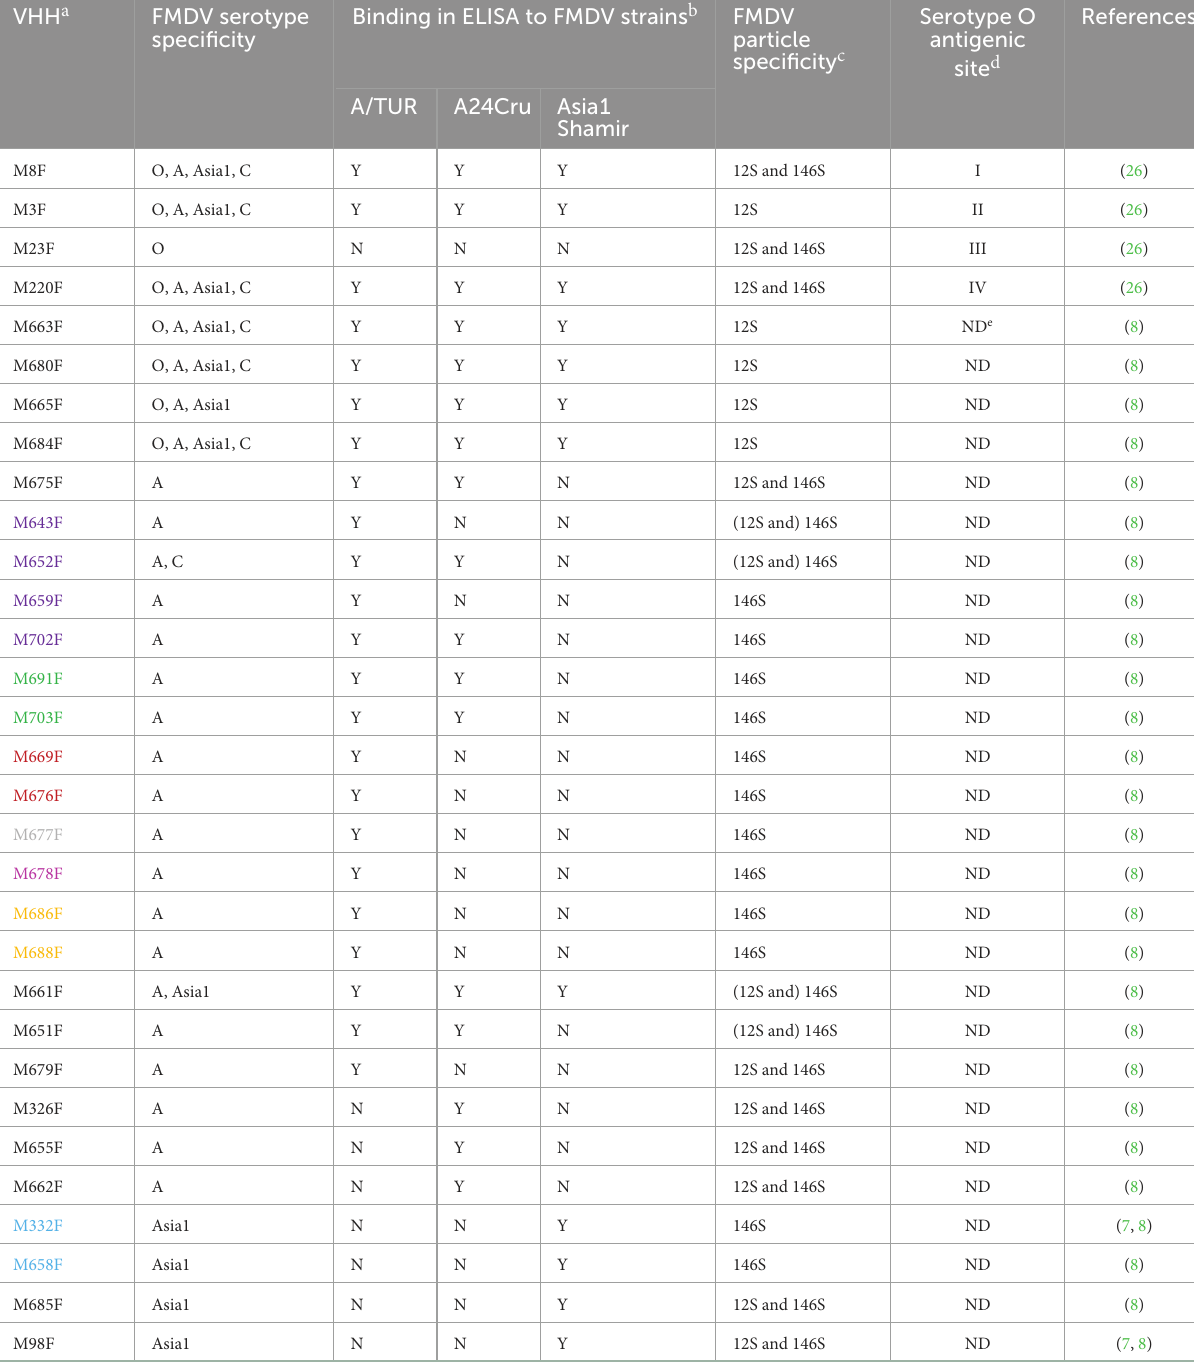
TABLE 1 FMDV serotype, strain, and particle specificity of previously-isolated VHHs used. VHH